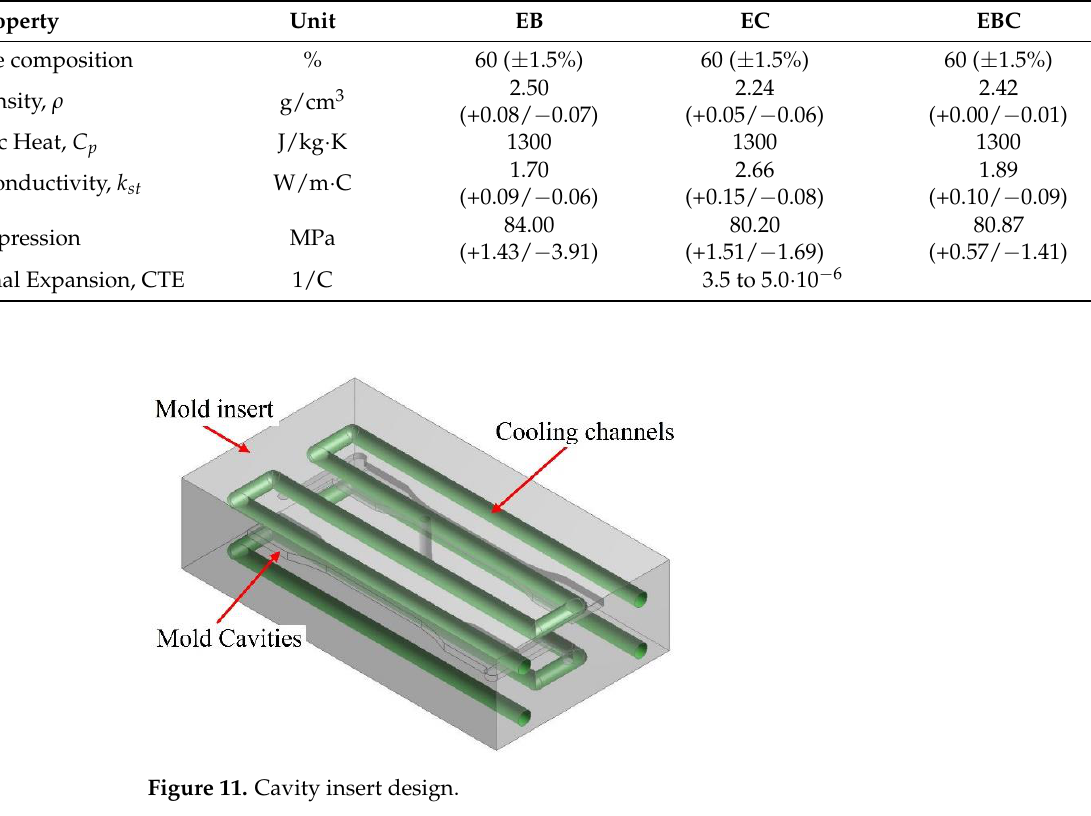
Table 4. Properties of mold insert material at high thermal conductivity value.